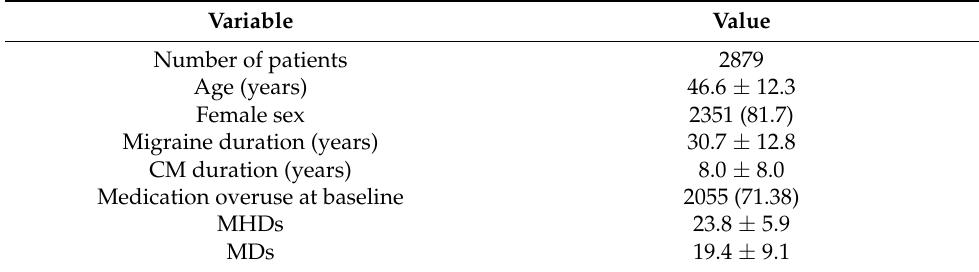
Table 1. Baseline characteristics of the analyzed